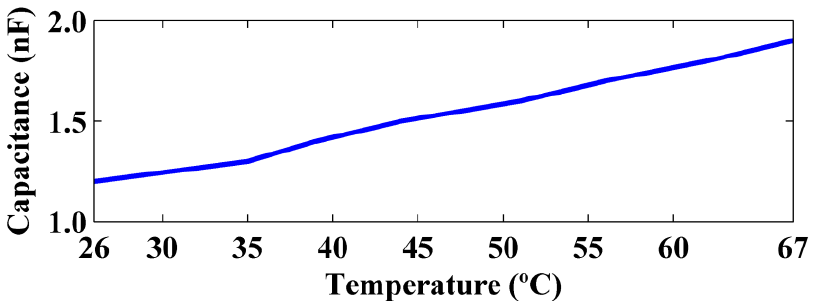
Figure 14. Capacitance as a function of the